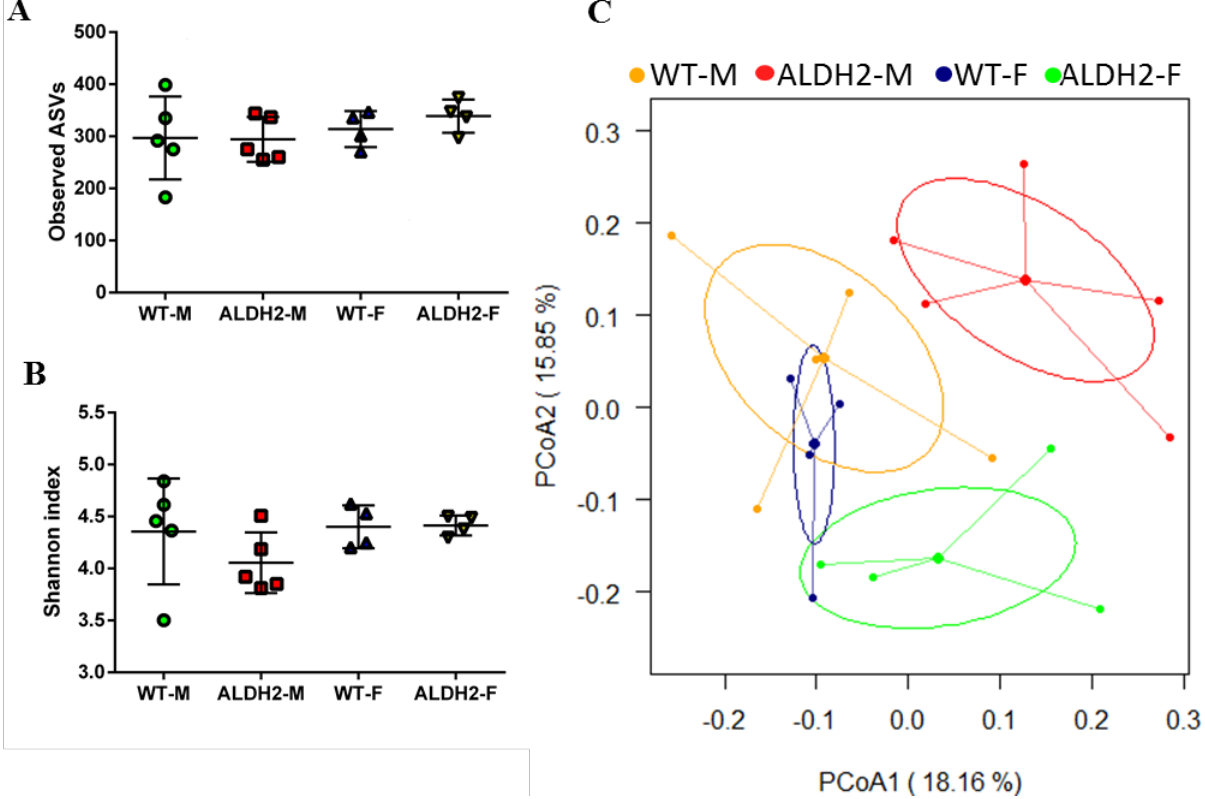
Figure 4. Microbiota composition and diversity in wild-type (WT) and ALDH2 mice. Microbiota composition in feces of HFD fed mice were analyzed using next generation sequencing ( n = 4–5 for each group). ( A ) Observed amplicon sequence variants (ASVs); ( B ) Shannon index; ( C ) Principal coordinate analysis (PCoA). Significant differences between ALDH2*2 vs. WT indicated: * p < 0.05.